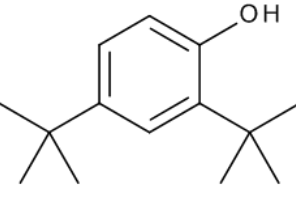
Figure 9. 2,4-Di- tert -butyl phenol.